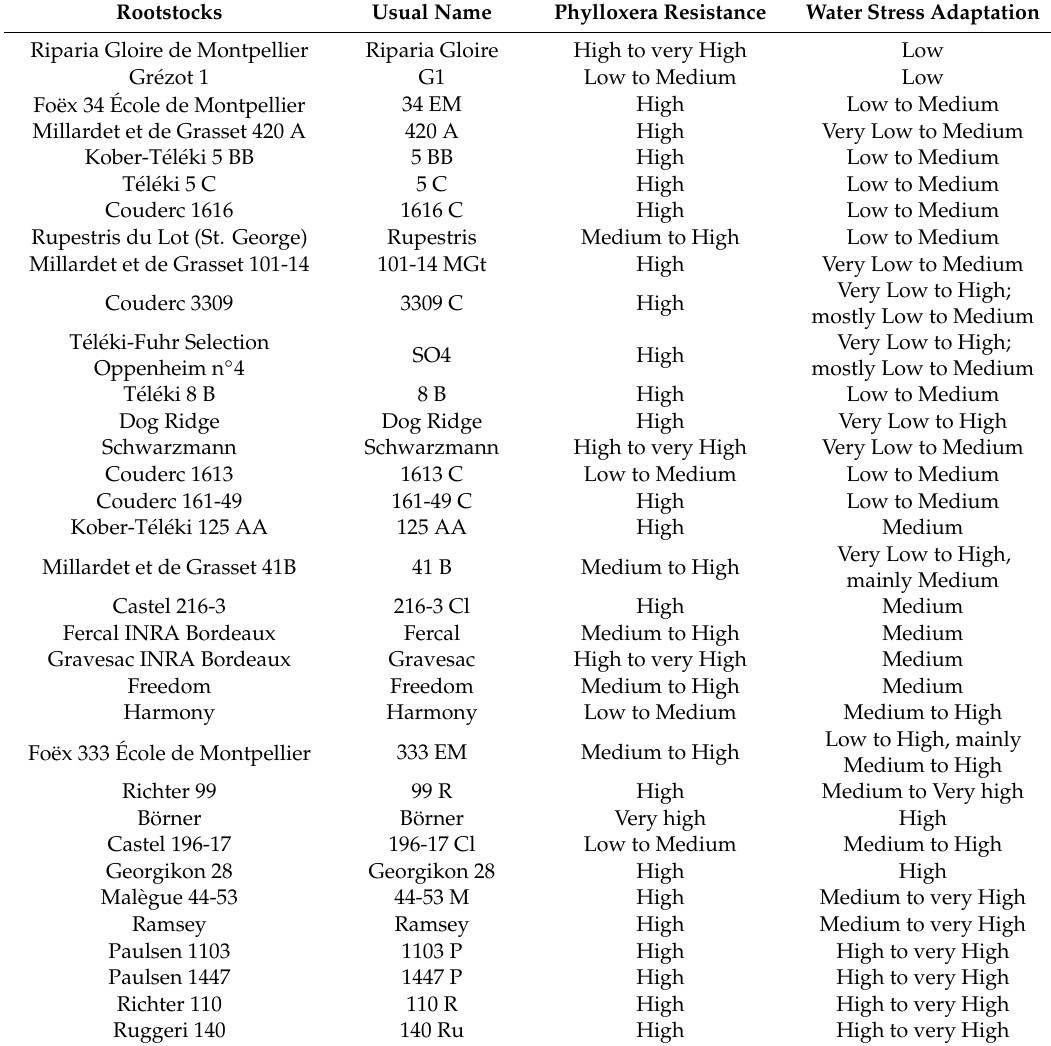
Table 1. Drought tolerance among rootstocks (Adapted from Ollat et al.